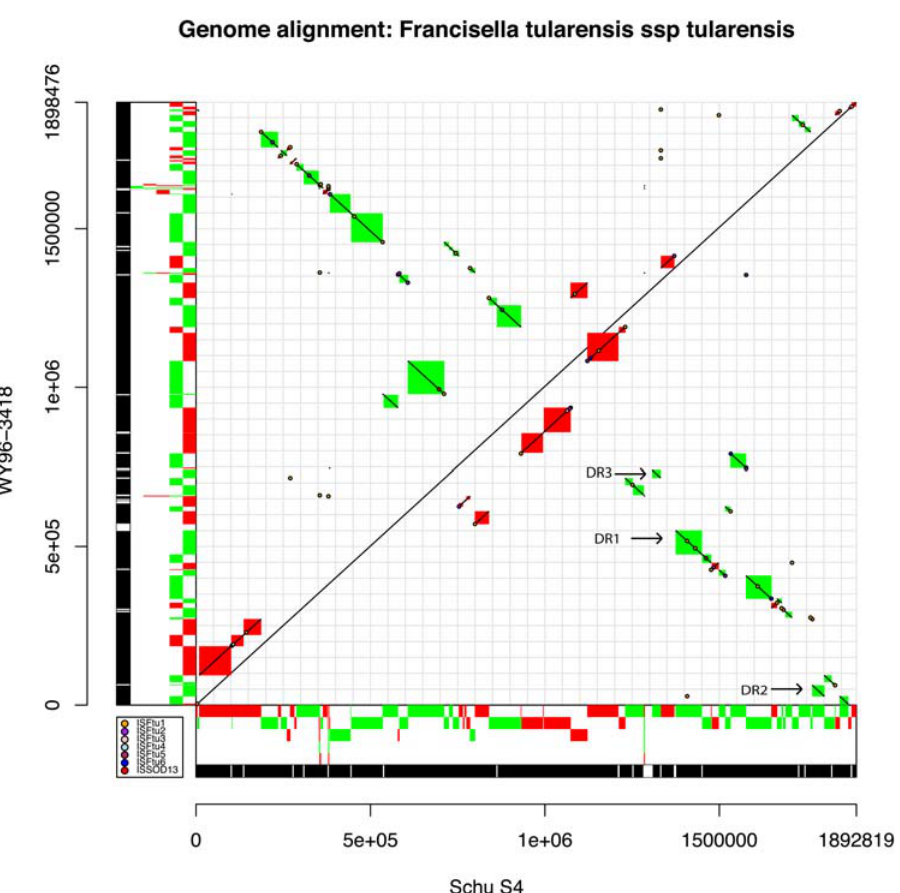
Figure 3. Dot plot comparison of MUMmer nucmer output [ 26 ] between Francisella tularensis subsp. tularensis strains Schu S4 and WY96. Plot generated from MUMmer coords file output using script written for R. Shared blocks of 1.5 Kb or greater were plotted as diagonal lines outlined in red (forward matches) and green (inversions). Positions of ISFtu elements (transposons) were plotted as colored spots (see legend). Red and green blocks on the axes correspond to forward and inversion matches, respectively, to the other genome, and different levels show overlapping matches. The black and white bars on each axis show overall matching regions (black) and gapped regions of no match (white). The two direct repeats (DR) diagonals are labeled DR1, DR2 along with the partial DR3 repeat (Table S4).